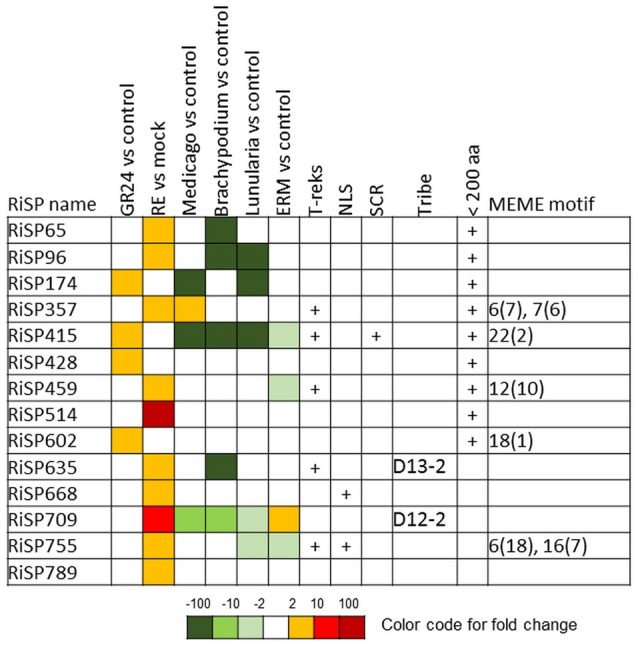
RiSPs of unknown function preferentially up-regulated after perception of plant signals. MEME motifs are described by their number (Figure 4 and Figure S2) and their occurrence (value within brackets).